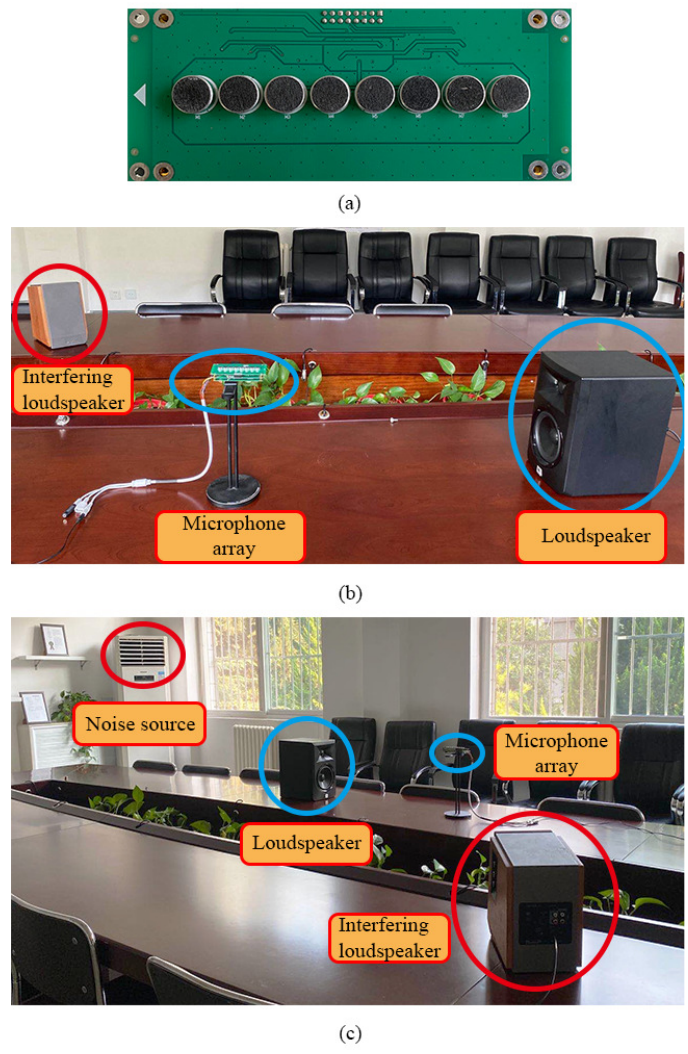
Figure 9. A photo of the designed array and the experimental setup for evaluating the binaural and conventional superdirective beamformers: ( a ) photo of the designed eight-microphone array, ( b ) a close view photo of the experimental setup, and ( c ) a wide angle photo of the experimental